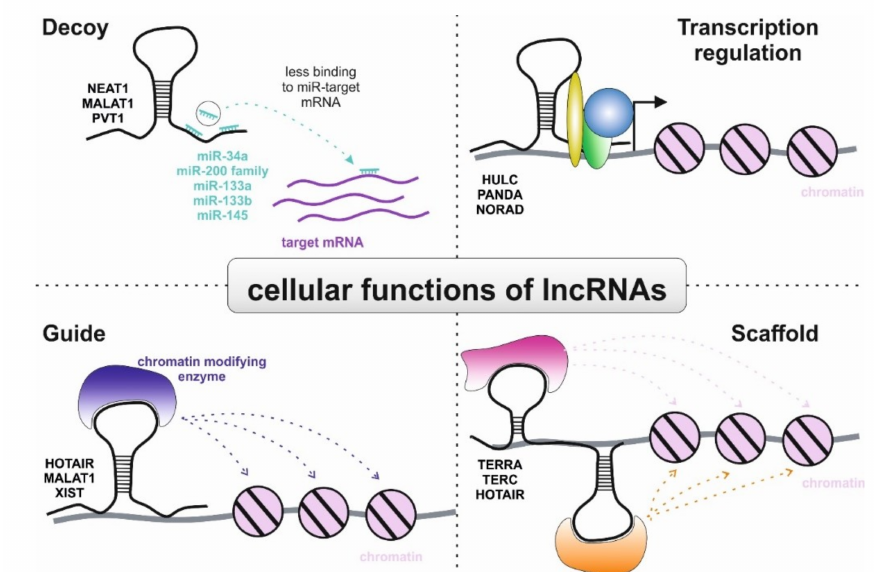
Figure 2. Graphical overview of cellular lncRNA actions. Decoy: long non-coding RNAs (lncRNA) can act as molecular sponges for miRNAs and transcription factors (not depicted), thereby preventing these molecules from binding to their actual targets. Transcription regulation: in combination with diverse transcription factors, lncRNAs possess the ability to regulate cellular transcription. Guide: lncRNA can act as guides for chromatin-modifying enzymes to target genes. Sca ff old: lncRNAs are able to form ribonucleoprotein complexes with di ff erent protein partners. This complex, consisting of lncRNAs and proteins can regulate transcription. In each panel, representative examples of lncRNAs are